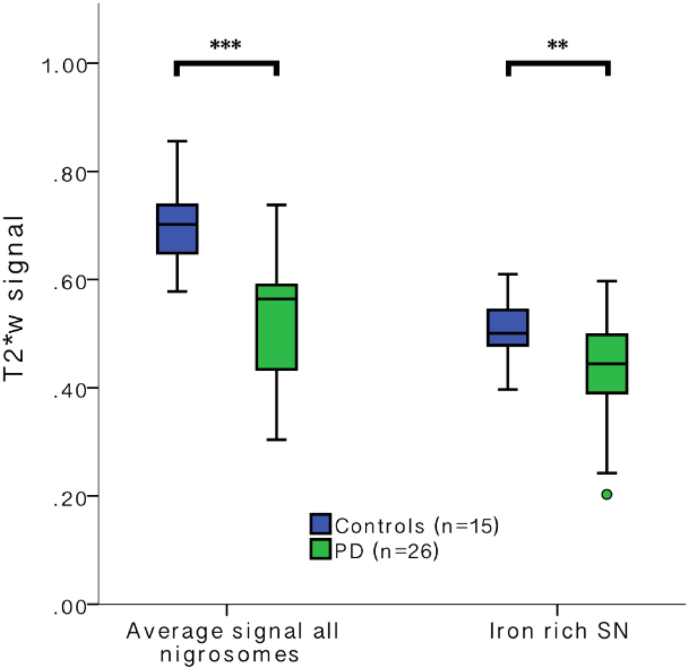
Nigrosomal and iron-rich SN T2*w signal in controls and PD.Box and whiskers plot of T2*w signal (normalised to WM in brainstem tegmentum) in all the nigrosomes and the surrounding iron-rich SN in Controls and PD. (***p < 0.001, **p < 0.01, Mann-Whitney U test).